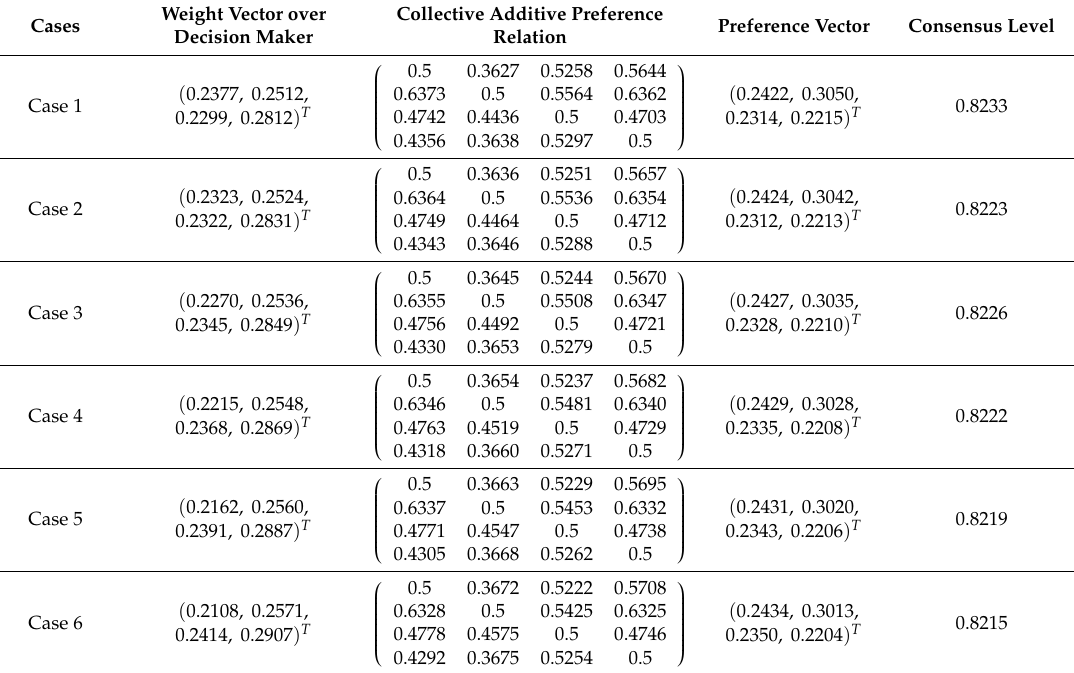
Table 3. Comparison